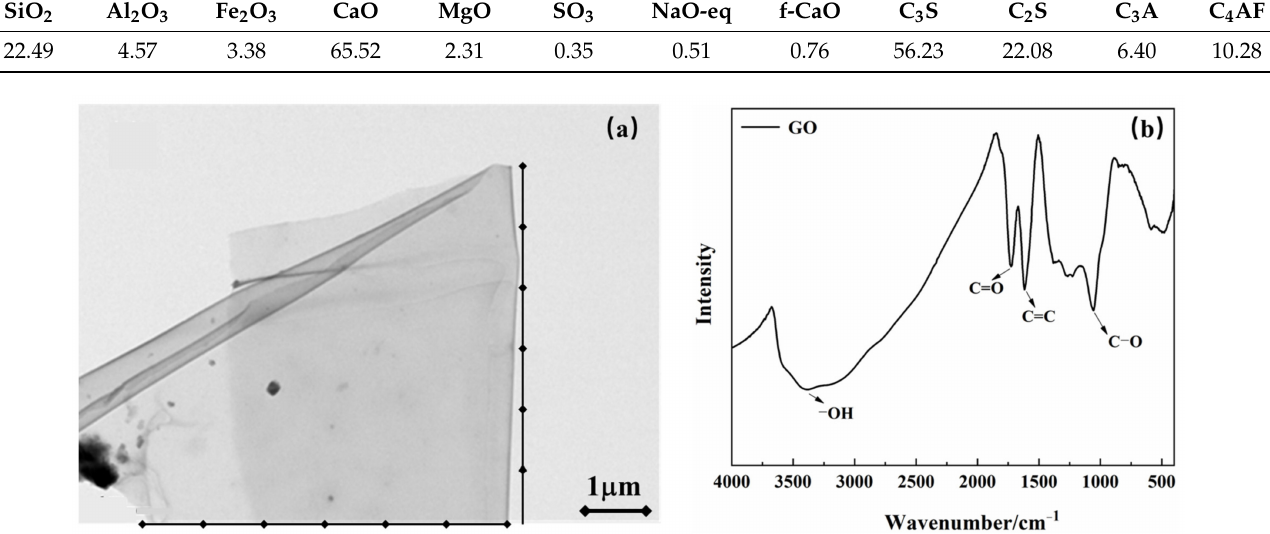
Figure 1. Microscopic morphology and functional-group composition of GO: ( a ) transmission electron microscopy image; and ( b ) Fourier-transform infrared spectrum.